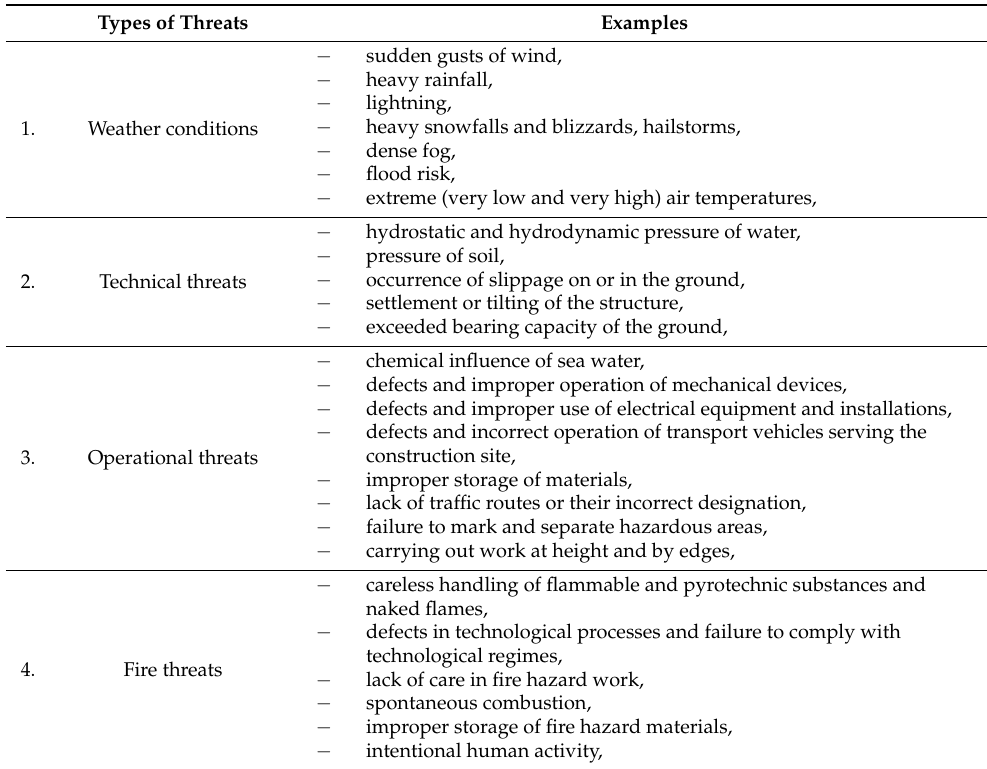
Table 1. Threats in land area of the